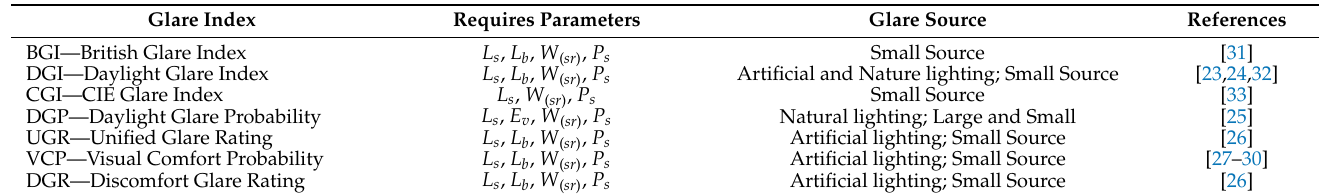
Table 1. Glare indices with required